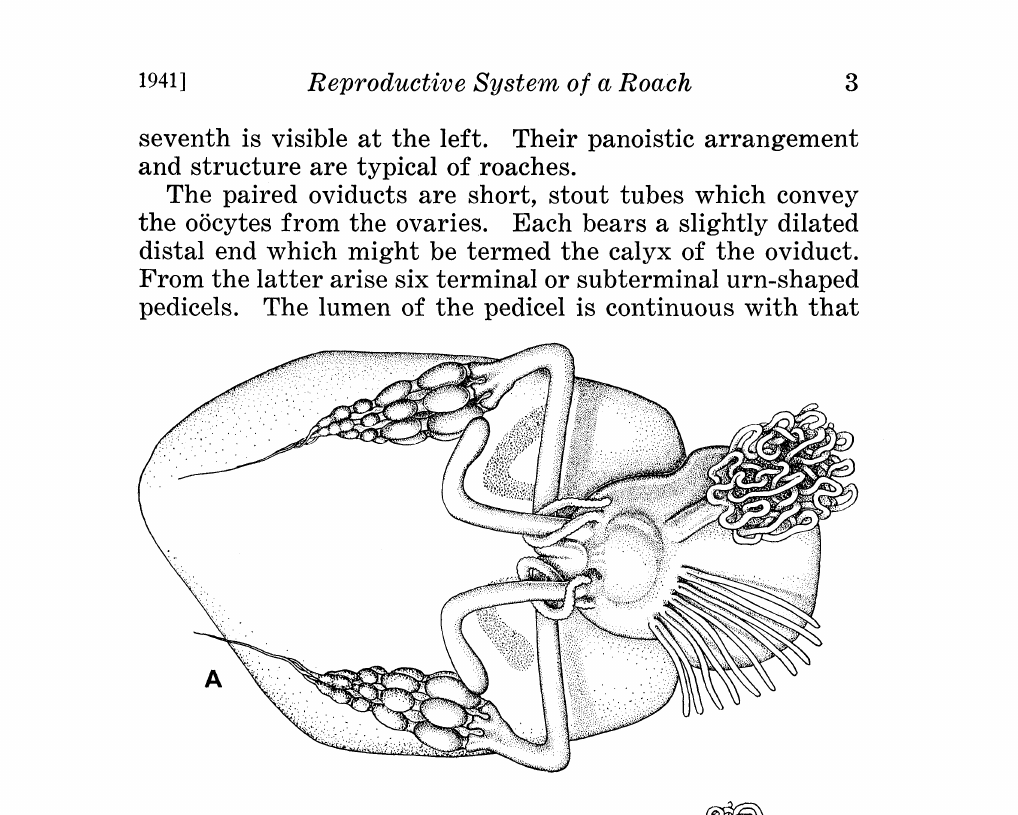
Figure 2. Diploptera dytiscoides. Diagrammatic views of the emale reproductive system. A, dorsal aspect above; B, lateral aspect below. BR.S, brood sac; GEN.P, genital pouch; L.GL, left accessory gland; O, ovary; OV, oviduct; R.GL, right accessory gland; SP, spermatheca; SP.GL, spermathecal gland; V, vulva; VE,